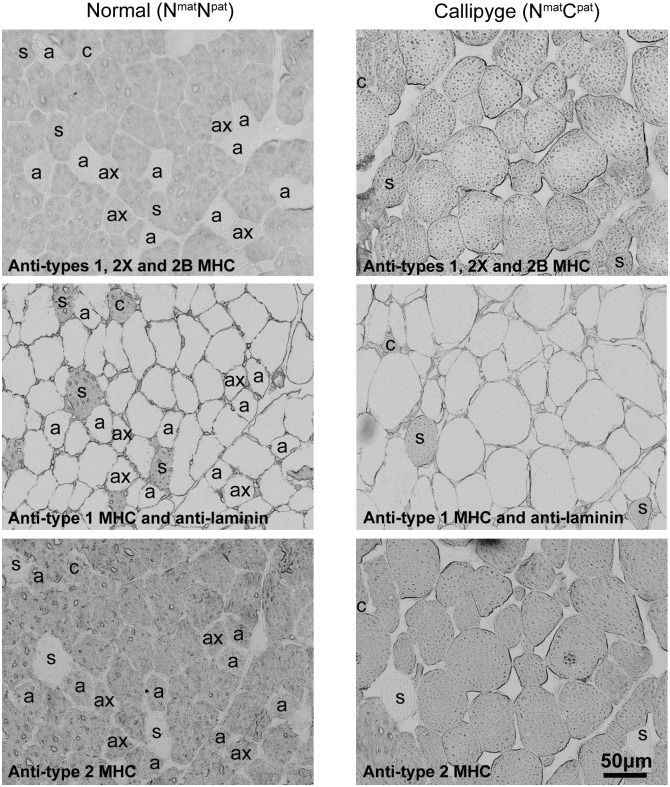
Immunohistochemical staining of ovine myosin heavy chains and laminin in serial sections of semimembranosus muscle.Representative myofibers are indicated: s, type 1 (slow oxidative); a, type 2A (fast twitch oxidative-glycolytic); c, type 2C (type 1–type 2A intermediate); ax, type 2AX (type 2A–type 2X intermediate). Non-labelled myofibers represent type 2X (fast twitch glycolytic). The top, middle and bottom panels were stained with myosin heavy chains (MHC) antibodies S5 8H2, WB-MHCs and MY32, respectively. Note the larger type 2X myofibres in the semimembranosus muscle of Callipyge (NmatCpat genotype) (right column) compared with normal (NmatNpat genotype) (left column) lambs, and the absence in the sections shown here and the overall very low prevalence of type 2A and type 2AX myofibres in Callipyge compared to normal semimembranosus muscle (see Table 1).